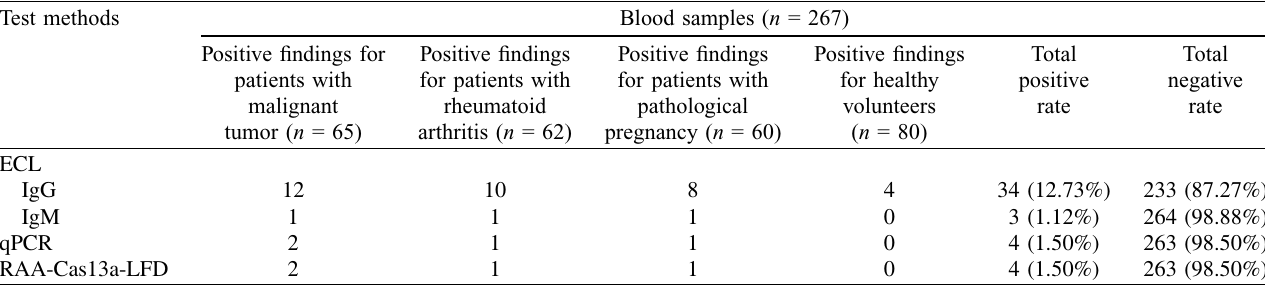
Table 3. Comparison of the results by ECL, qPCR and RAA-Cas13a-LFD assay for detection of T. gondii in the blood samples. Test